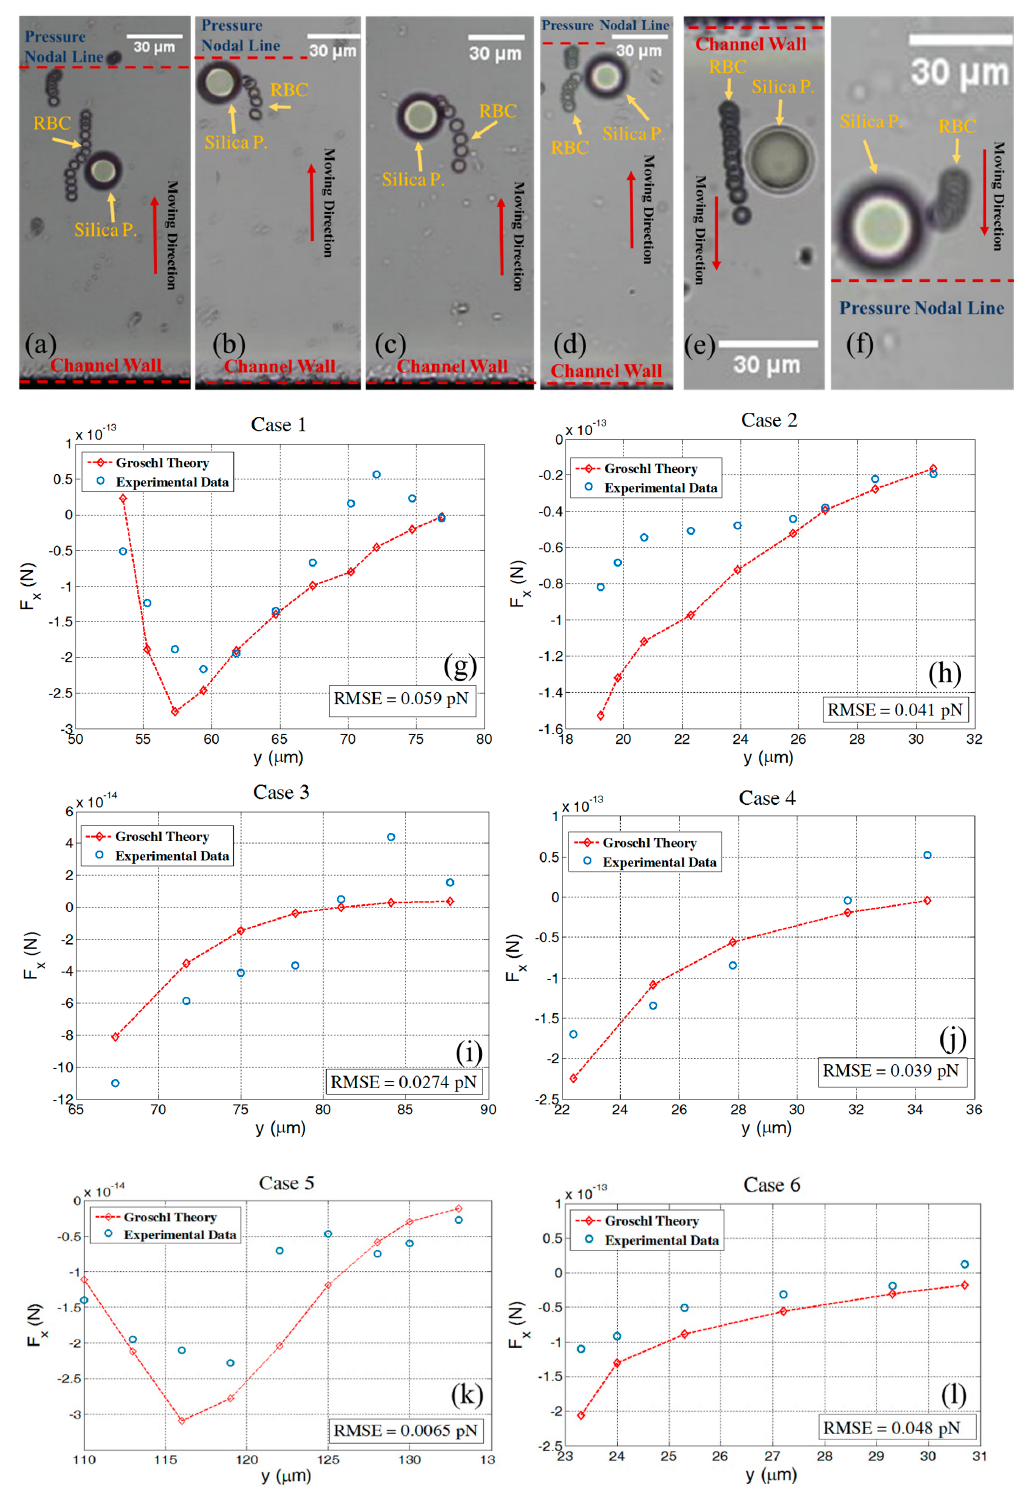
Figure 3. Time series of RBC pathways ( a – f ), cases 1 to 6, respectively, and experimental and theoretical comparison of the secondary acoustic force while RBCs pass by a fixed 20 µ m silica particle based on the extended Gröschl model ( g – l ). Standard deviations of the residuals were shown for each case (root mean square error, RMSE). In ( c , e ), the pressure nodal line is outside of the picture. In ( f ) the channel wall is outside of picture. The center of the fixed silica particle in ( g , i ) is located at 65 µ m, in ( h , j , l ) at 20 µ m, and ( k ) at 128 µ m from the pressure nodal line (the latter set to y =